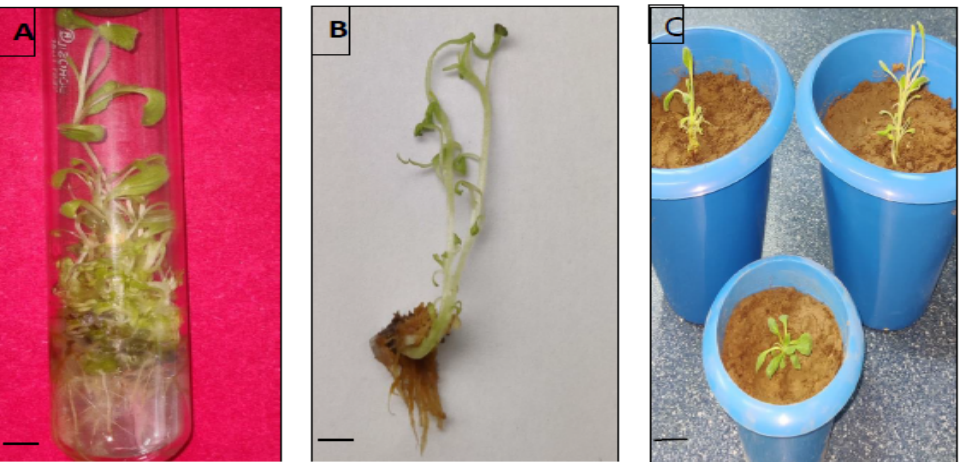
Figure 7. ( A , B ) Root induction of in vitro regenerated D. purpurea plants (bars = 1.0 cm). ( C ) Tissue culture raised D. purpurea plants in pots (bar = 3cm).